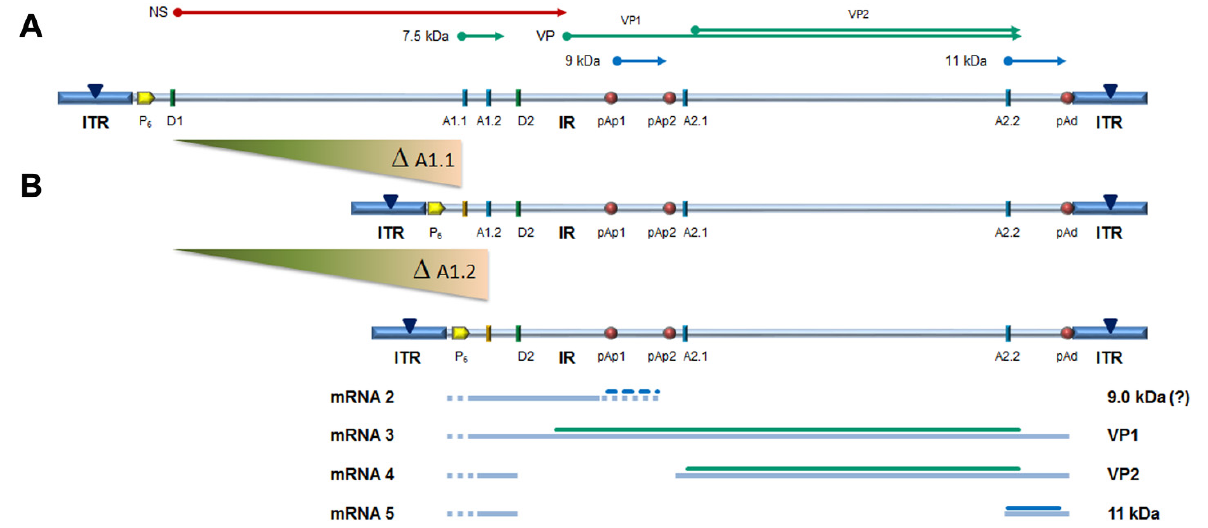
Figure 6. ( A ) Map of B19V genome, see Figure 1. ∆ : deletion to remove first intron (A1.1/2). ( B ) Map of B19V derived minigenomes; simplified transcription map, indicating the four classes of mRNAs (mRNA 2–5), with alternative splicing/cleavage forms (dashed lines) and related coding potential.